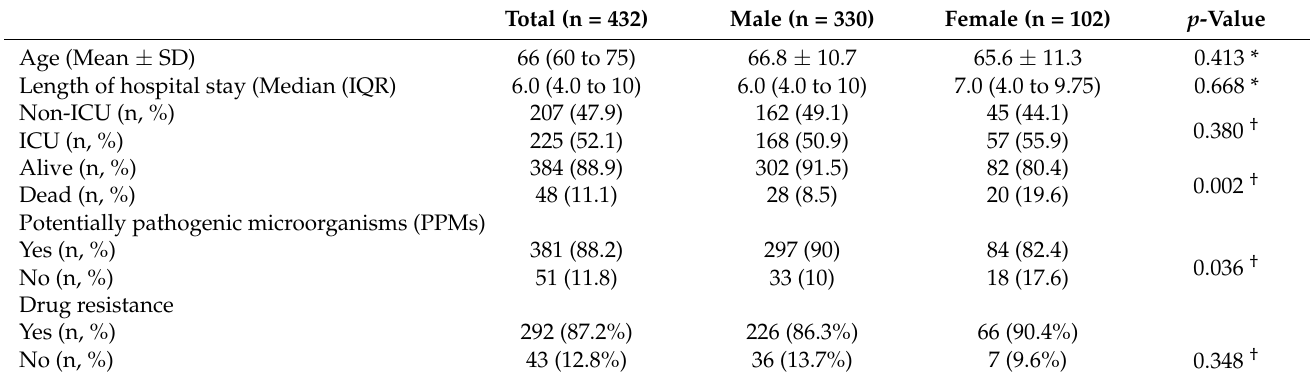
Table 1. Describes the clinical, demographic, microbiologic characteristics, survival of the study subjects, and the test of significance between the male and female subjects with